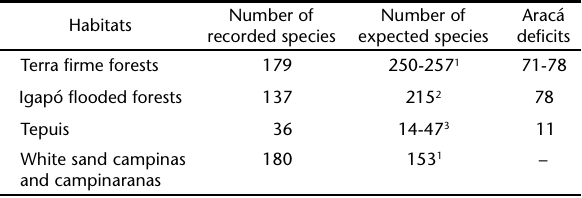
Table II. Harrison indices calculate in paired comparisons between major vegetation types in the Aracá